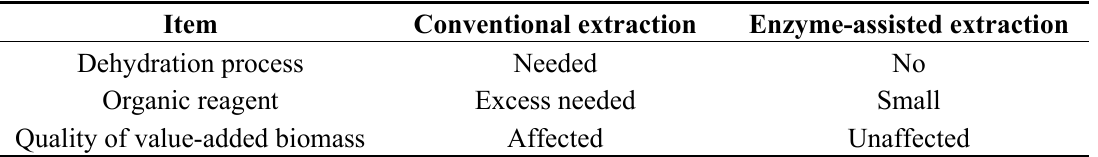
Table 1. Comparison with conventional extraction